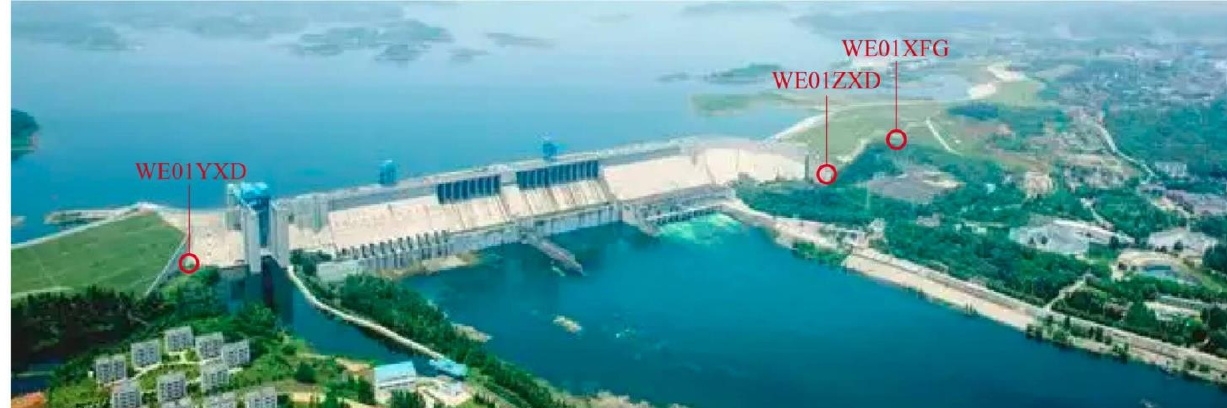
Figure 3. The locations of three measuring weirs.